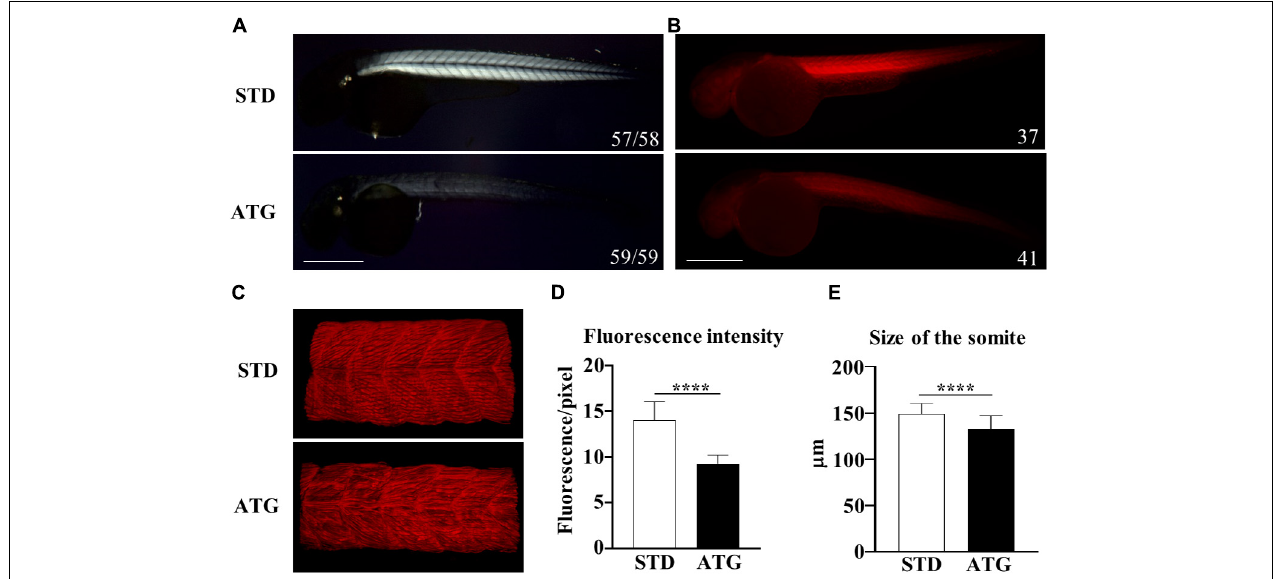
FIGURE 6 | Birefringence analysis and F-actin staining. (A) Birefringence quantification in embryos injected with STD or ATG morpholino at 48 hpf. (B) Embryos were incubated with fluorescent phalloidin to stain F-actin. Representative lateral views of stained embryos showing the clear reduction of the total fluorescence intensity in ATG-morphants. Images were acquired with the same parameter, as described in section “Materials and Methods.” (C) Lightsheet imaging of a section of the trunk in the embryos as in (A) . The image of the ATG-morphant was adjusted in order to show a fluorescence intensity comparable to that of the control embryo (STD). (D) Quantification of the fluorescence of embryos shown in (A) , acquired by ZF-Mapper software. (E) Mean size of the trunk in control and ATG-morphants at 48 hpf, measured as described in section “Materials and Methods.” Three (birefringence) and two biological replicates (phalloidin staining) were performed. Numbers in each image indicate the total number of embryos analyzed. Size bar = 500 µ m. **** P < 0.0001 (unpaired, two-tailed T